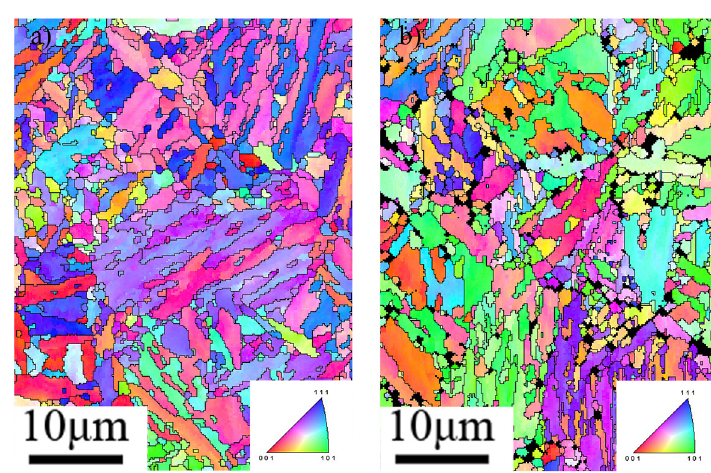
Figure 8. EBSD analysis results before and after USRP treatment (IPF plots): (a) untreated (b) USRP